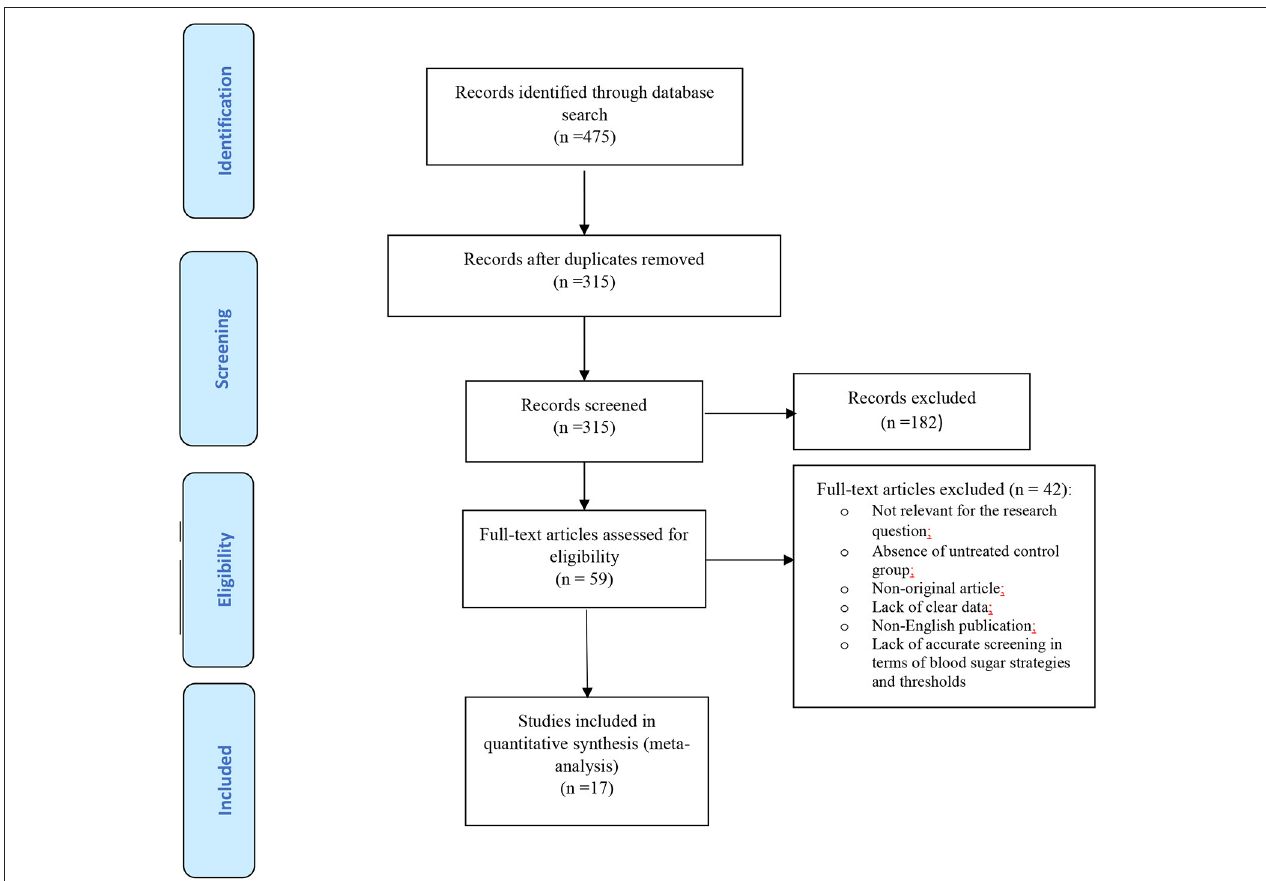
FIGURE 1 | Flow diagram of the search strategy and study